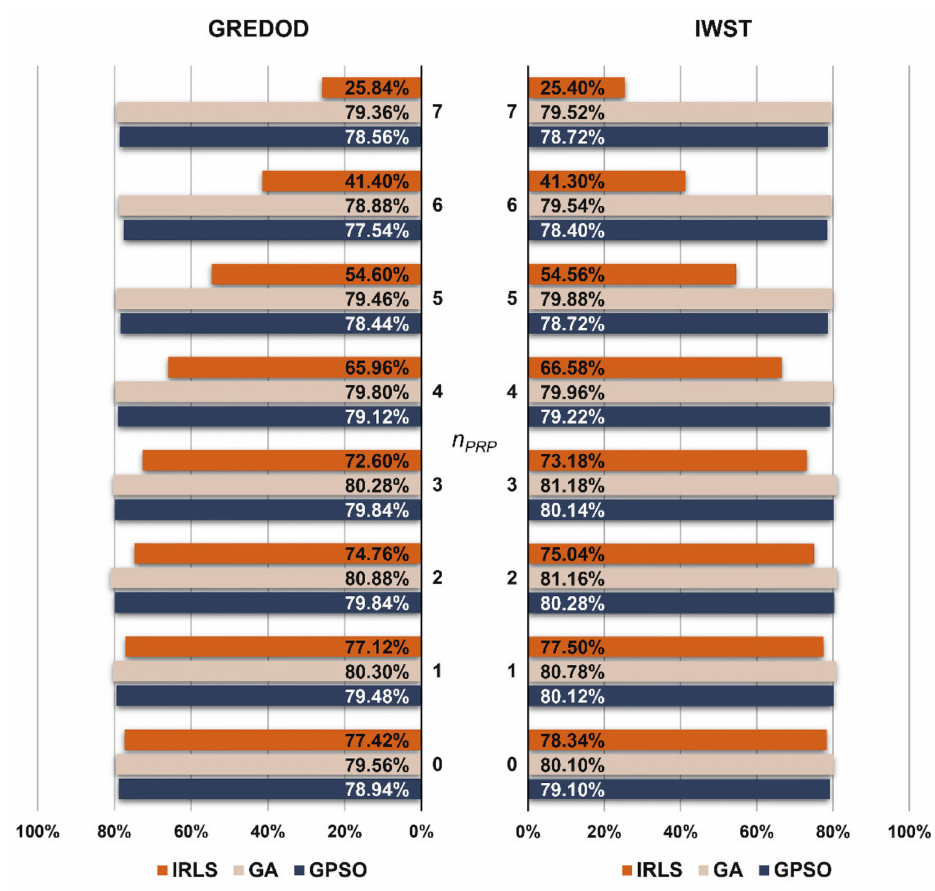
Figure 5. MSRs of GREDOD and IWST methods for variant